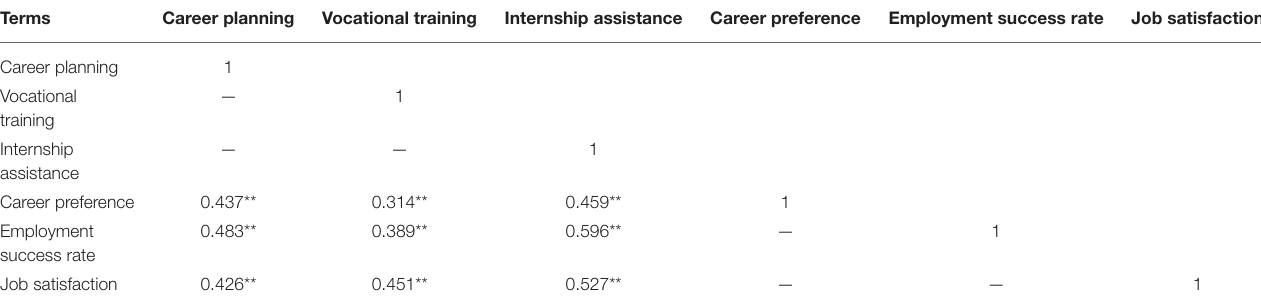
TABLE 9 | Correlation analysis of factors of key variables.